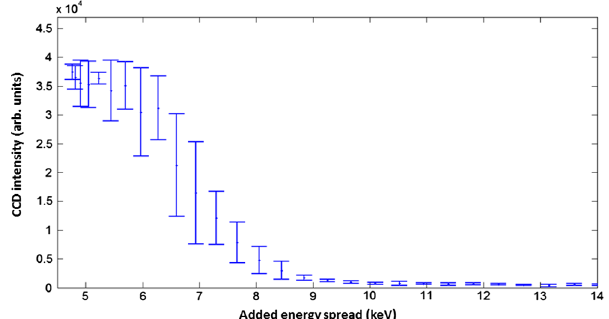
FIG. 9. OTR intensity measured at linac exit plotted vs laser heater-added energy spread, for a 350 pC bunch charge com- pressed by a factor 10 in BC1. During these measurements and those in Fig. 10, the LH laser spot size was 220 × 220 μ m 2 (rms) at its waist and the pulse duration was ∼ 13 ps